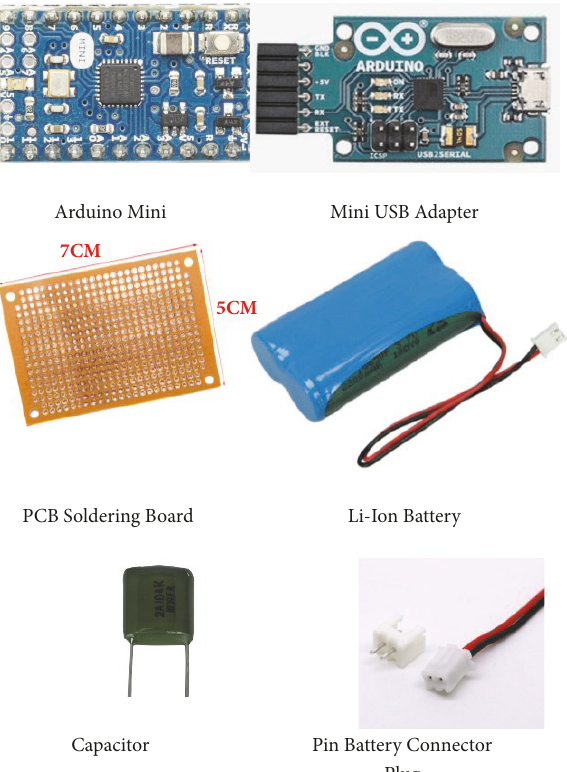
Figure 3: Hardware components for improved version of the system [13–18].